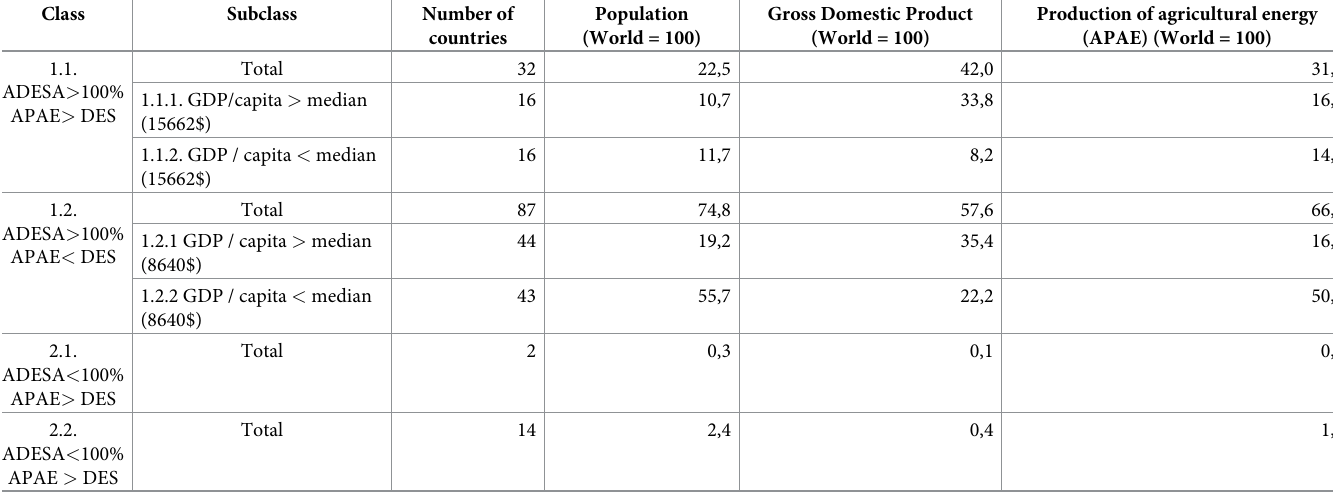
Table 1. Importance of countries grouped in specific classes and subclasses on a global scale (2000–2013 average